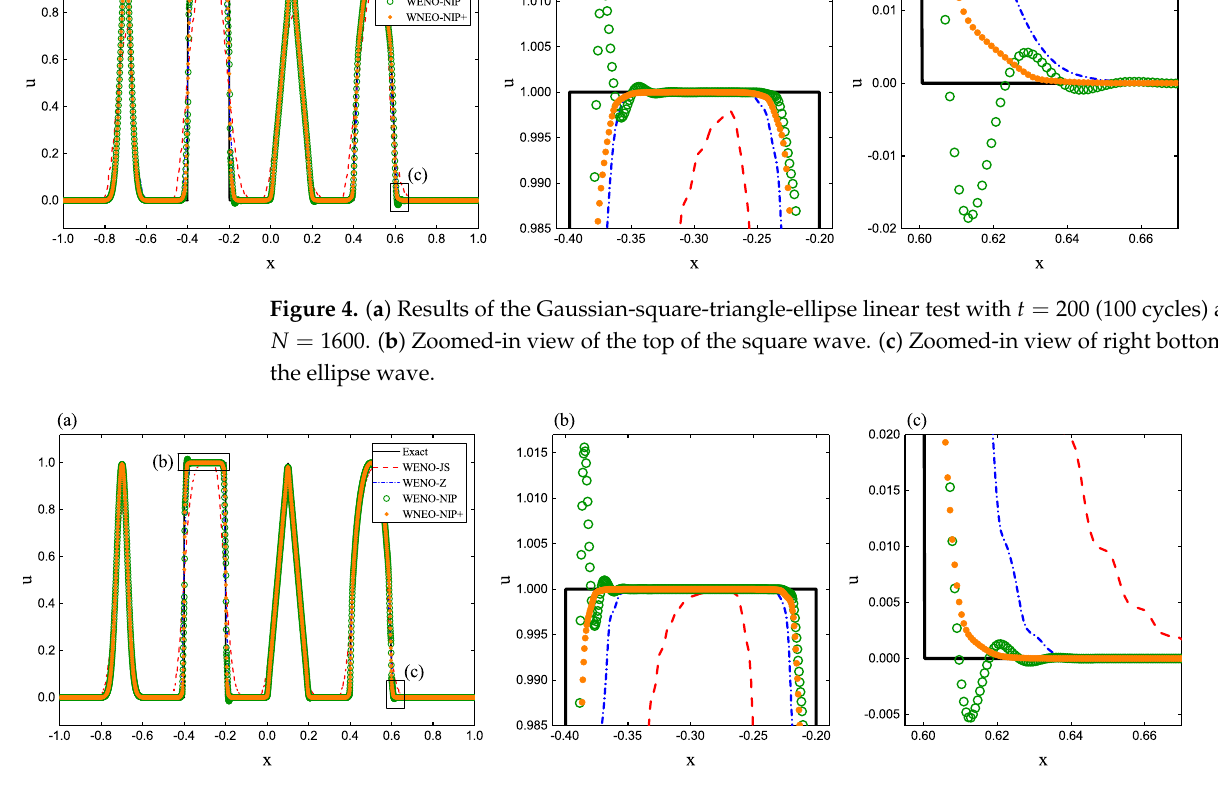
Figure 5. ( a ) Results of the Gaussian-square-triangle-ellipse linear test with t = 200 (100 cycles) and N = 3200. ( b ) Zoomed-in view of the top of the square wave. ( c ) Zoomed-in view of right bottom of the ellipse